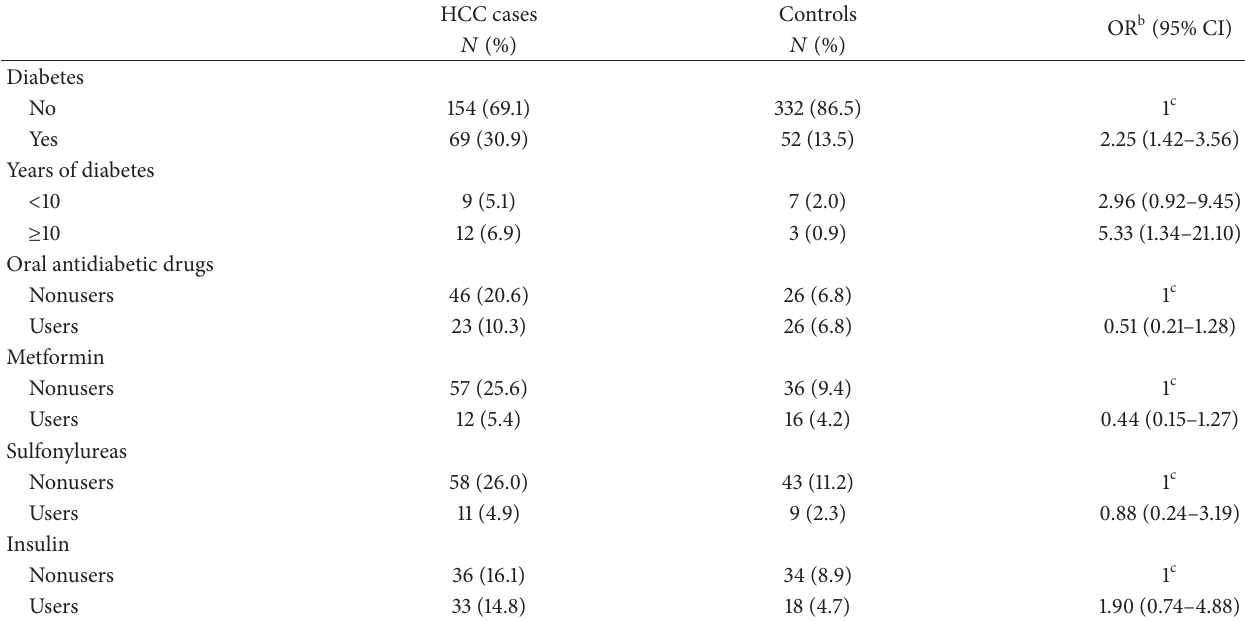
Table 2: Distribution a of 224 hepatocellular carcinoma (HCC) cases and 389 controls, and corresponding odds ratios (OR) and 95% confidence intervals (CI), according to history of diabetes (Italy, 2005–2012).